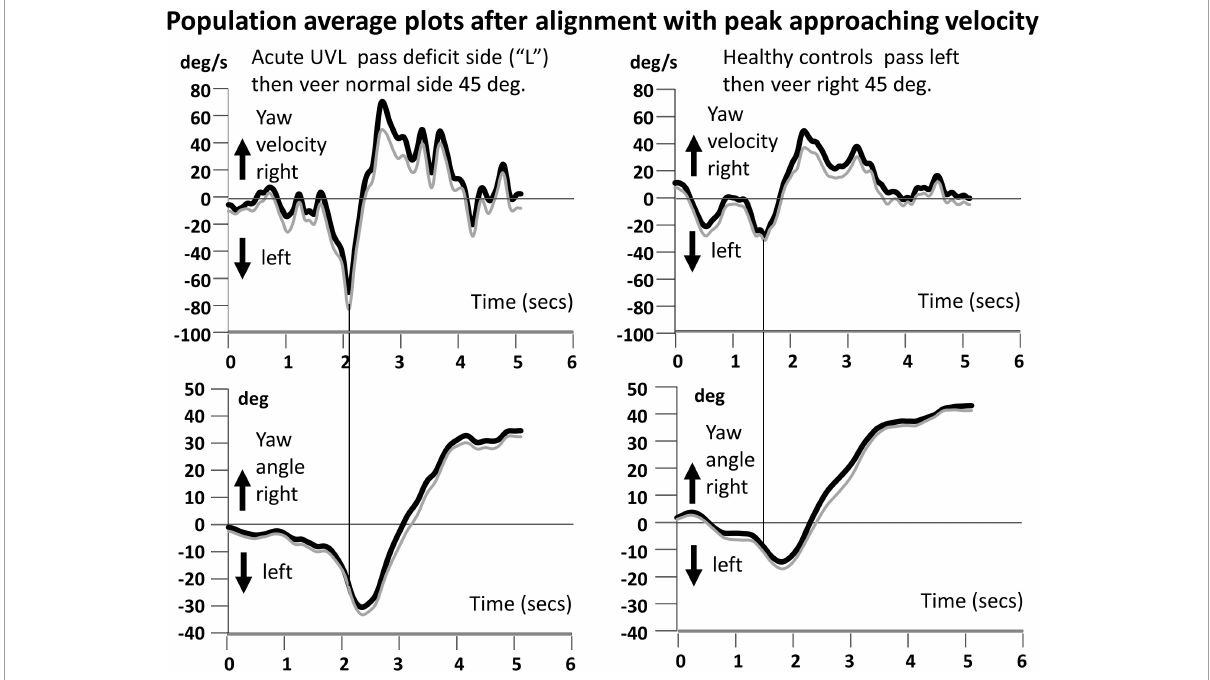
FIGURE4 Population average yaw velocity plots for the circumvention task of walking to the obstacle, passing it on the aUVL side, and then veering to the right (left traces). On the right are the traces of the healthy controls. The angle traces in the lower plots show the veering trajectories. Details of the plots are described in the legends to Figures 1 , 3 .